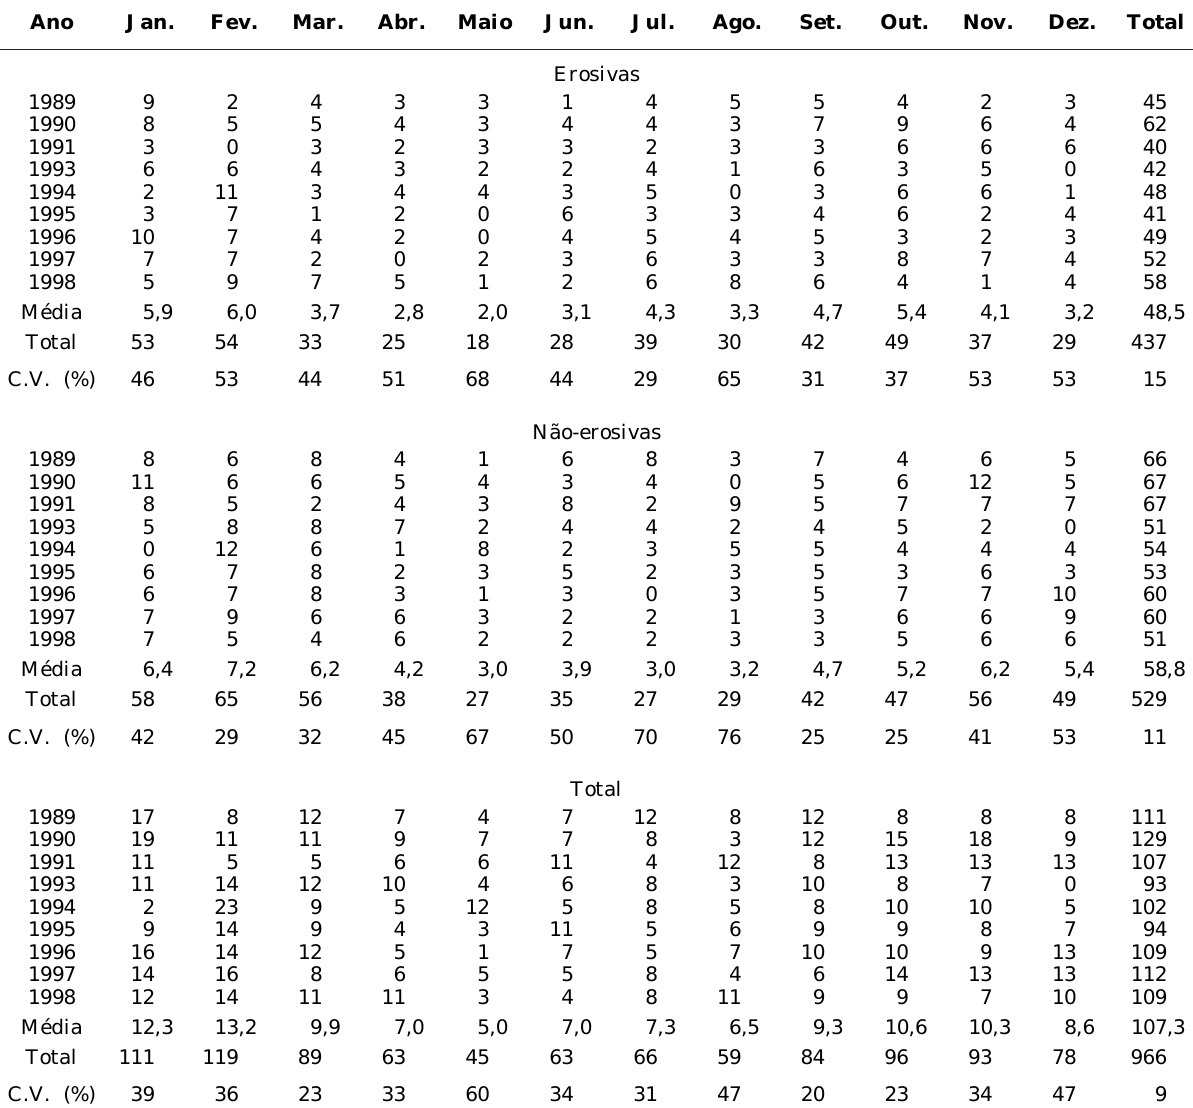
Quadro 1. Valores mensais, anuais e médios mensais e anual dos números de chuvas erosivas, não- erosivas e total, observadas no período de 1989 a 1998 em Lages (SC)